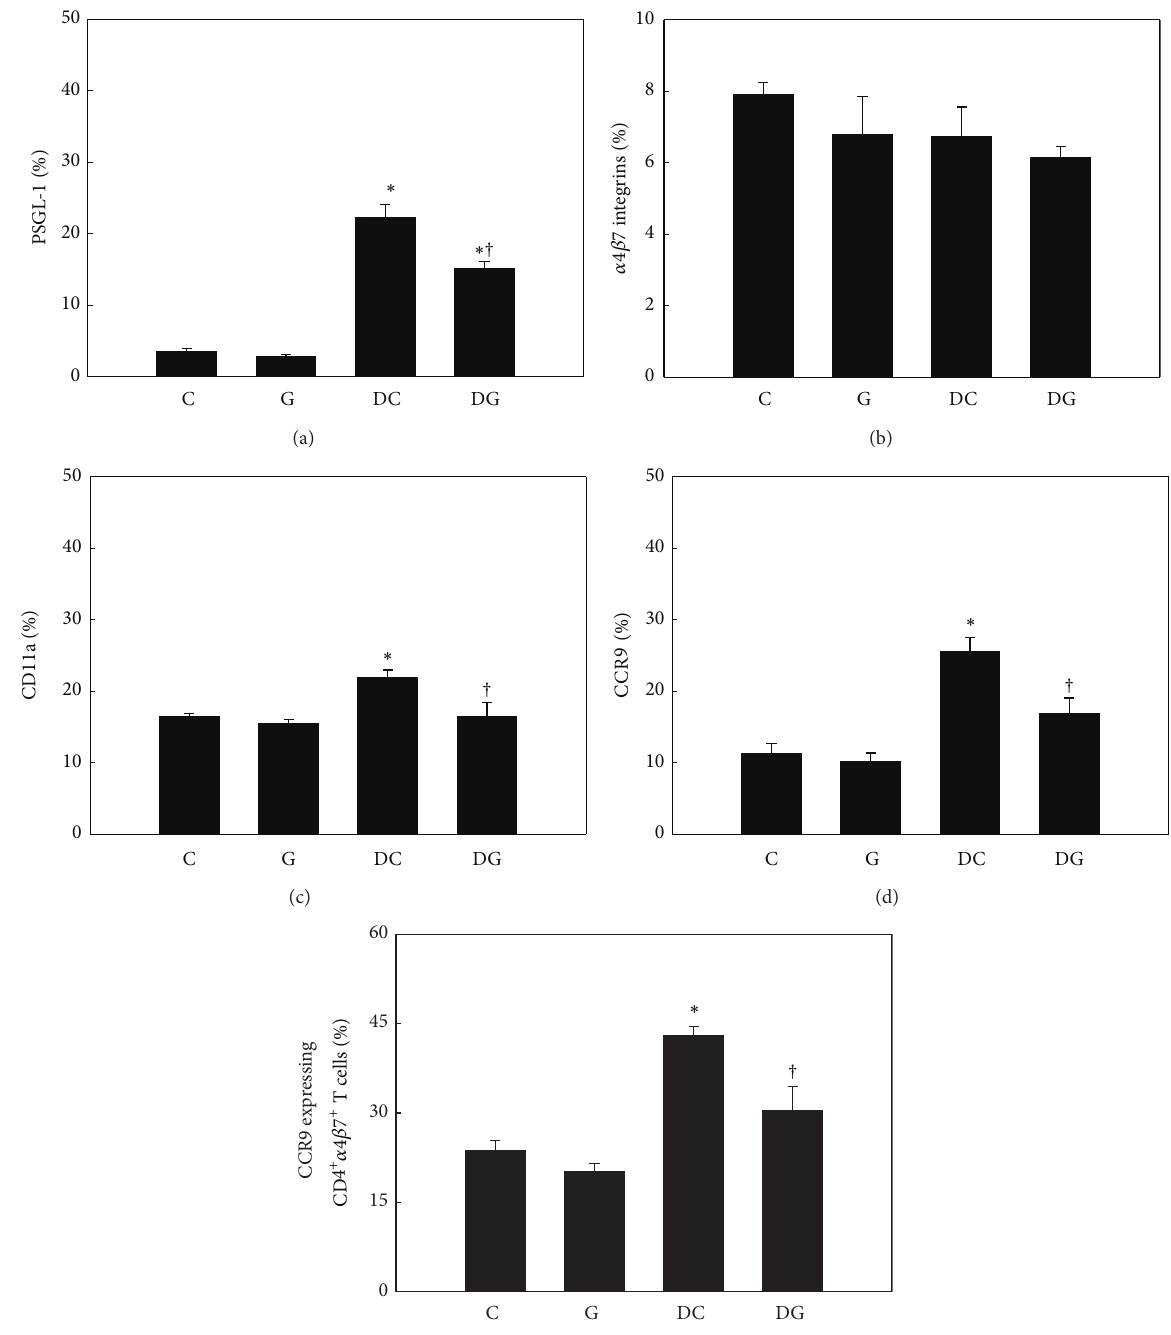
Figure 5: Percentage of adhesion molecule- and chemokine receptor-expressing T helper (Th) cells in mesenteric lymph nodes (MLNs). CD4-positive MLN lymphocytes were gated to analyze expressions of PSGL-1, 𝛼4𝛽7 integrins, CD11a, and CCR9 by flow cytometry ((a)–(d)). (e) Expression of CCR9 by CD4 and 𝛼4𝛽7 integrin double-positive MLN lymphocytes. Values are shown as the mean ± SEM. ∗ Significantly different from the C group ( 𝑃 < 0.05 ). † Significantly different from the DC group ( 𝑃 < 0.05 ).